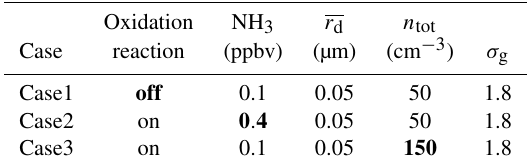
Table 3. Initial conditions for sensitivity test cases of the 2- dimensional kinematic model. Specified are aqueous-phase chem- istry choice, initial volume fraction of NH 3 , mean radius of the as- sumed lognormal aerosol particle size distribution r d , total aerosol concentration n tot , and geometric standard deviation σ g . Other pa- rameters for each case are the same as in the base case (Table 2) The parameters that distinguish each sensitivity test case are marked in